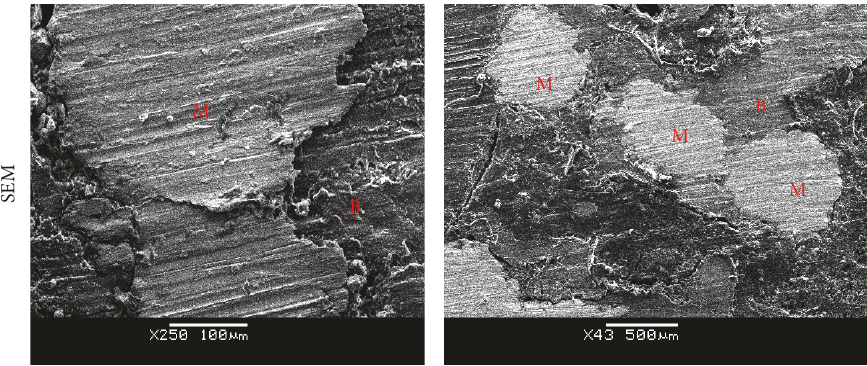
Figure 7: Bone-scaffold interface; SEM images show bone (B) in contact with the metal